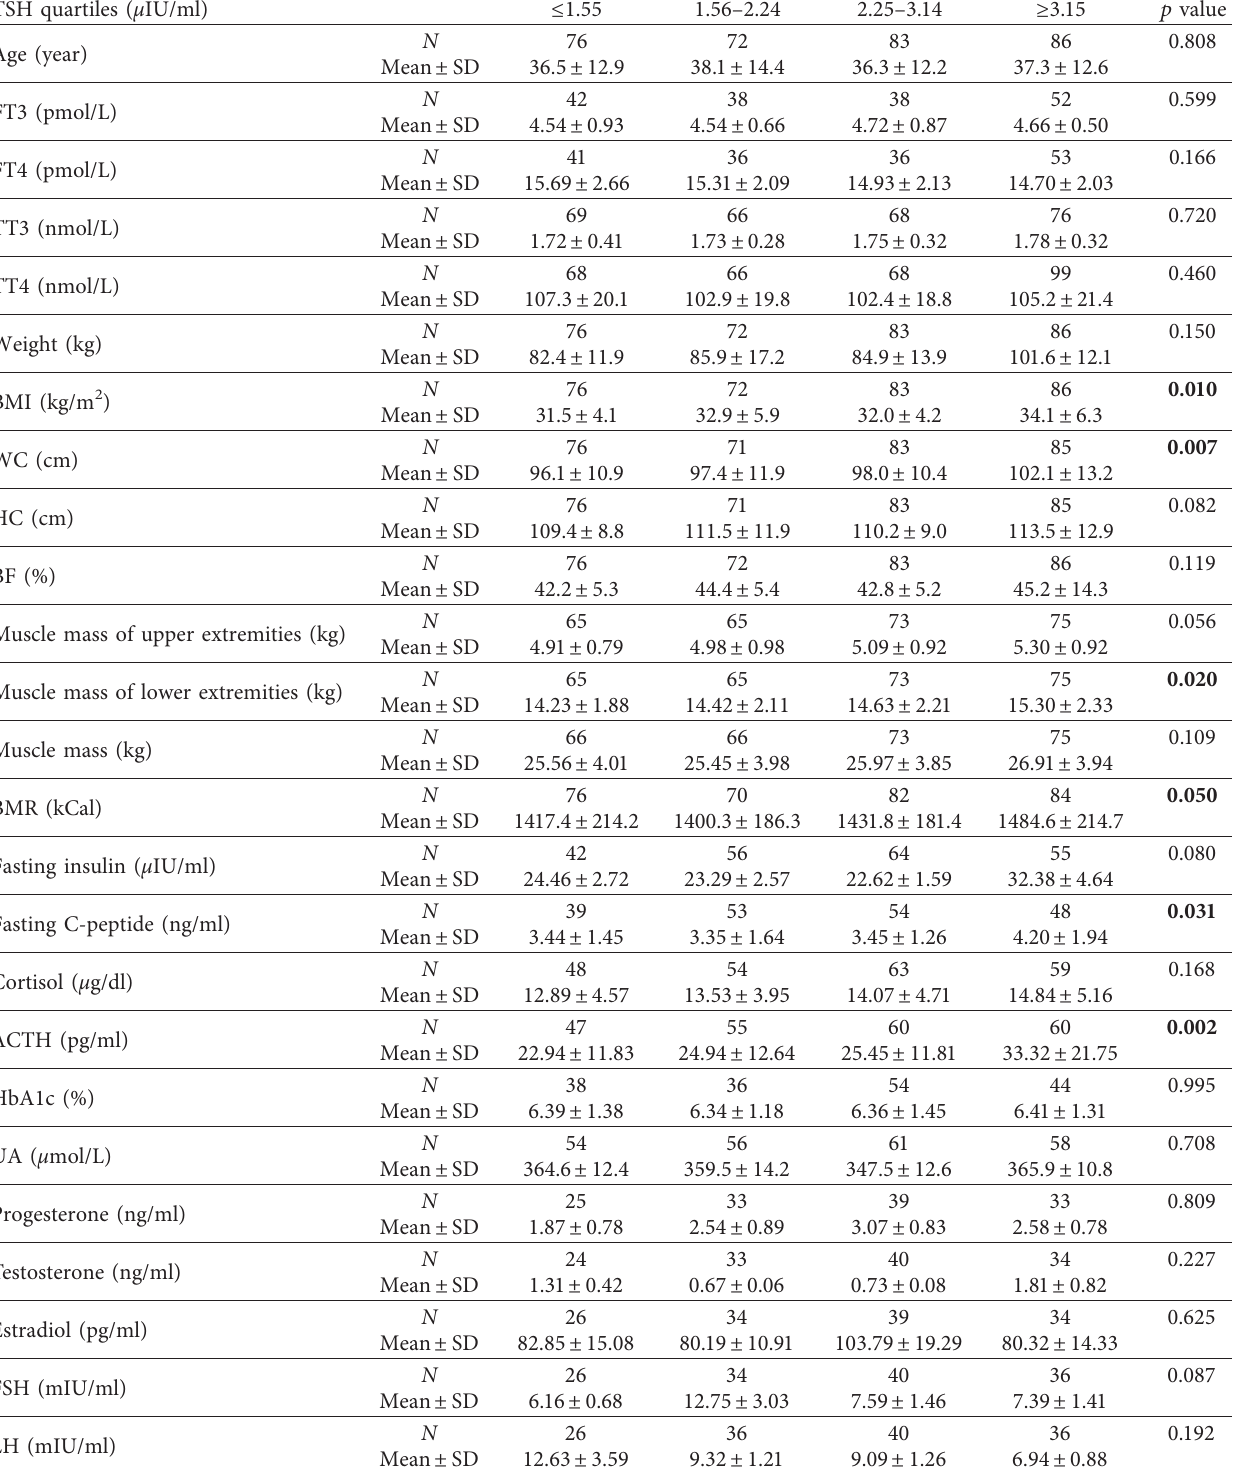
Table 2: The distribution of demographic data and metabolic indicators across the TSH quartiles in the female